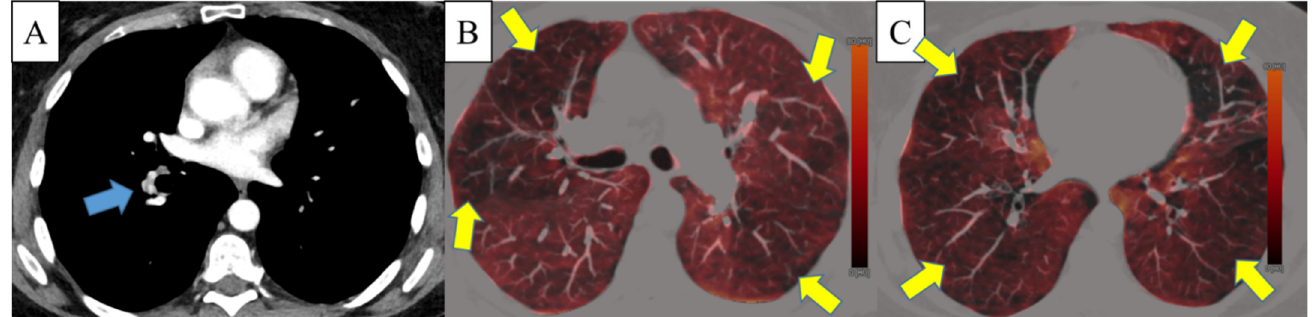
Figure 3. An exemplary case of a 46-year-old female with chronic thromboembolic pulmonary hypertension illustrating discrepant dual-energy CT findings of the radiological level of disease (distal disease with involvement of the basal trunk of the right lower lobe artery; level 2b, blue arrow on panel ( A )) and extensive perfusion defects (yellow arrows on panels ( B ) and ( C ).